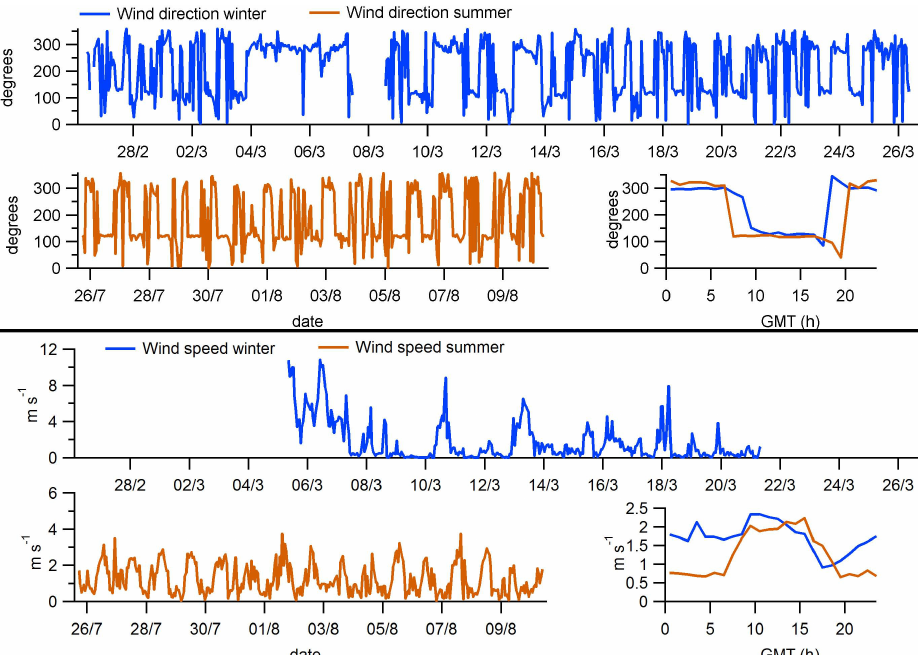
Fig. 3. Wind direction and speed during the winter period (upper graph of each panel), during the summer period (lower left graph) and their mean daily cycles (hourly averages) for both periods (lower right graph). Note the different scaling for graphs on wind speed seasonal trend graphs. Date labels indicate 00:00